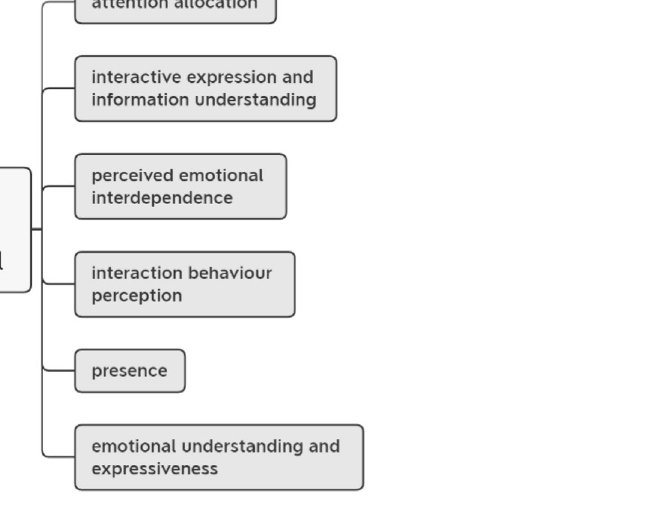
Figure 1. Original model of robots’ social